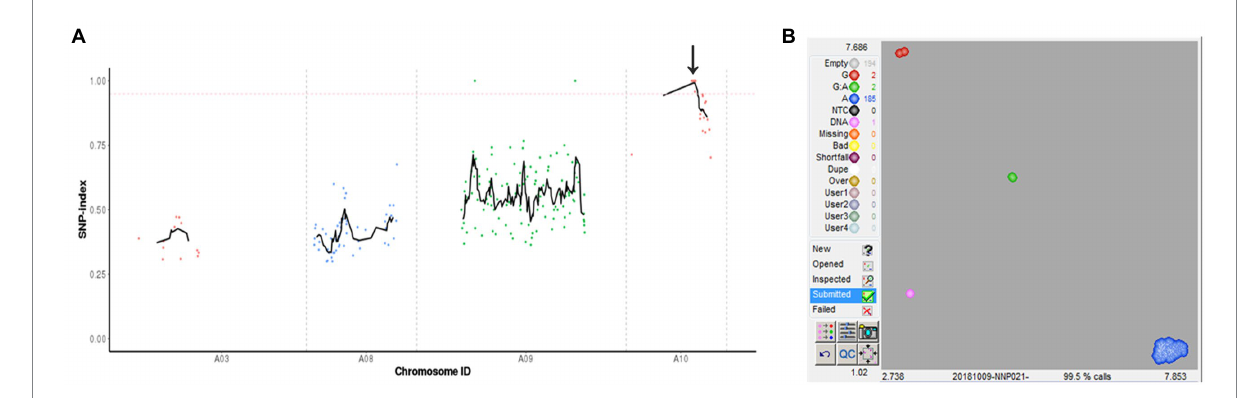
FIGURE 5 Identification of the msm2-1/2/3 candidate gene. (A) SNP index plot of ten chromosomes was produced by MutMap analysis. The x-axis represents the positions of the ten chromosomes and the y-axis represents the SNP index. The dotted pink line represents the index threshold (0.95). (B) The results of SNP genotyping arrays of